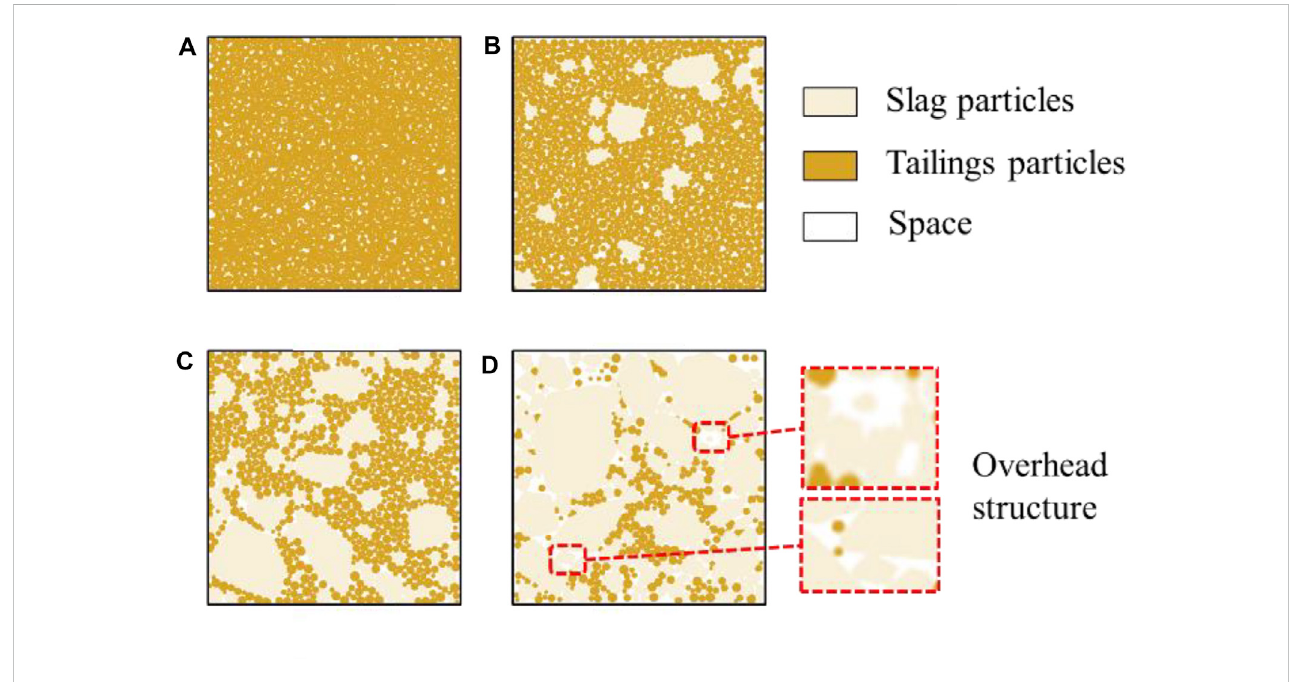
FIGURE 4 Schematic diagrams of TSM microstructure